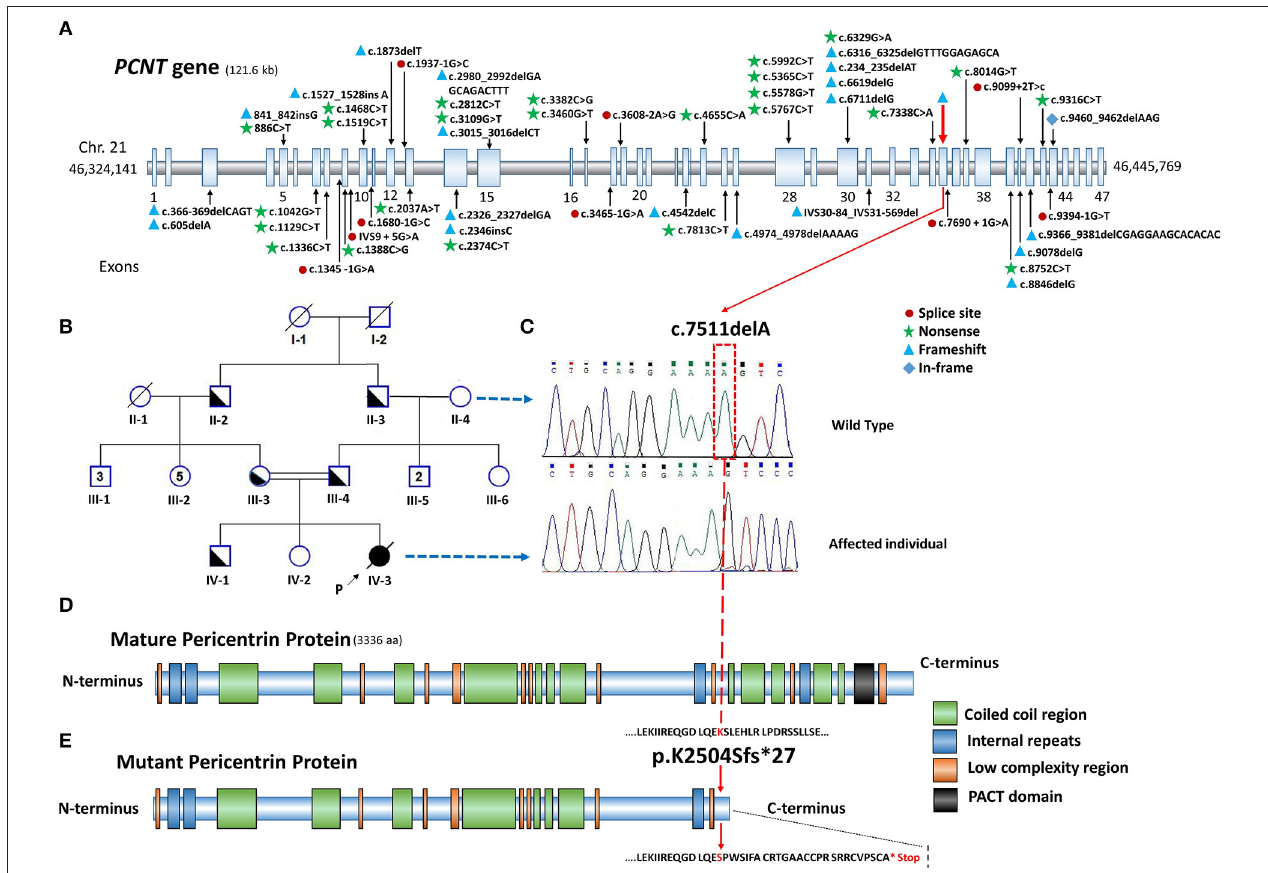
FIGURE 3 | (A) Schematic presentation of PCNT gene on chromosome 21 with reported pathogenic variants associated with MOPD II. (B) Pedigree of patient’s family, parents have consanguineous marriage. (C) Sanger sequencing confirmed the variant (c.7511delA) in the extended family, the patient (homozygote) and her paternal grandmother (unaffected) with corresponding chromatogram. (D) Schematic representation of mature Pericentrin protein with its domains and regions, data for drawing the protein domains and regions were recruited from SMART tool (Simple Modular Architecture Research Tool, http://smart.embl-heidelberg.de/, not drawn in scale). (E) p.K2504Sfs*27 causes premature protein with the loss of regions and domains near C terminus of protein, among which PACT domain (black domain) is a fundamental one for the appropriate function of Pericentrin